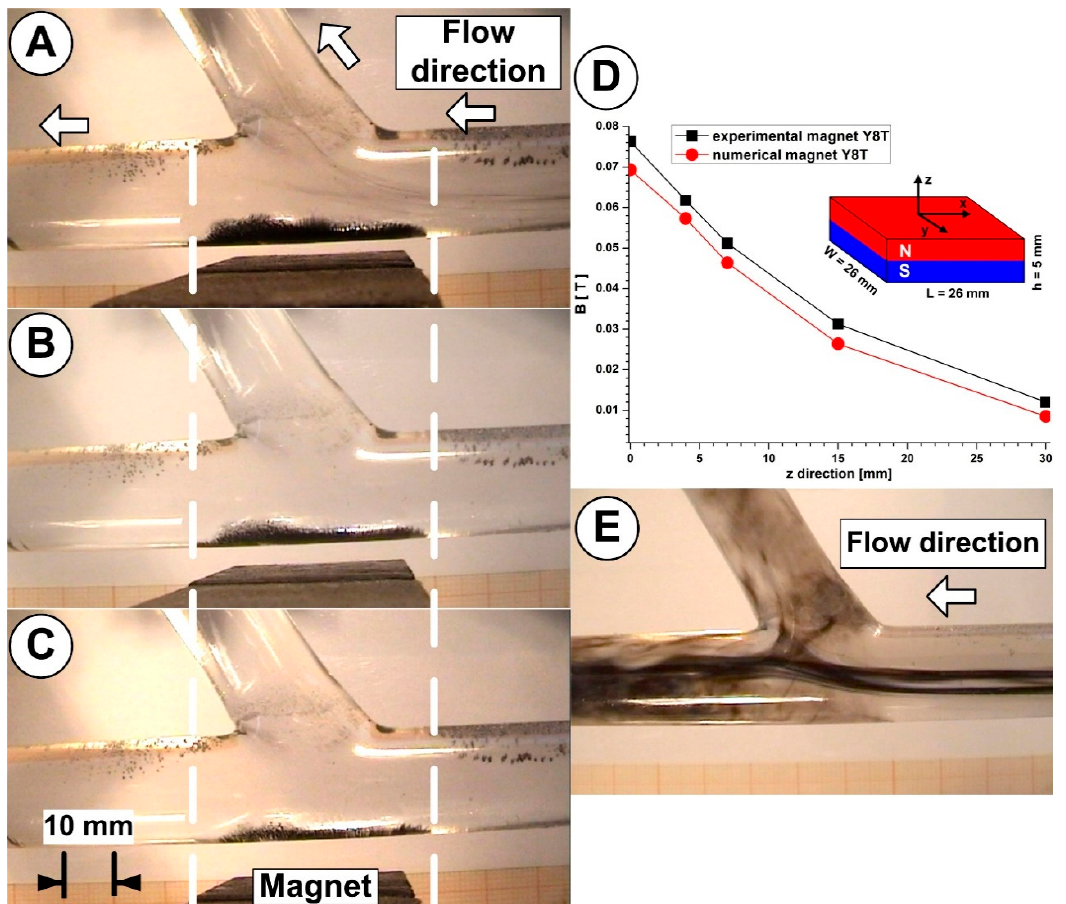
Figure 14. Particle accumulations in the bifurcation region for the different vertical positions of the magnet. ( A ) a magnet distance of 2 mm; ( B ) a magnet distance of 5 mm; ( C ) a magnet distance of 7 mm; ( D ) the magnetic field induction function of the distance to the magnet’s surface along the z -axis. The same working condition was applied for all magnet positions: an inlet velocity of 0.12 m / s, and an injection time of 30 s. ( E ) Flow evolution in the bifurcation